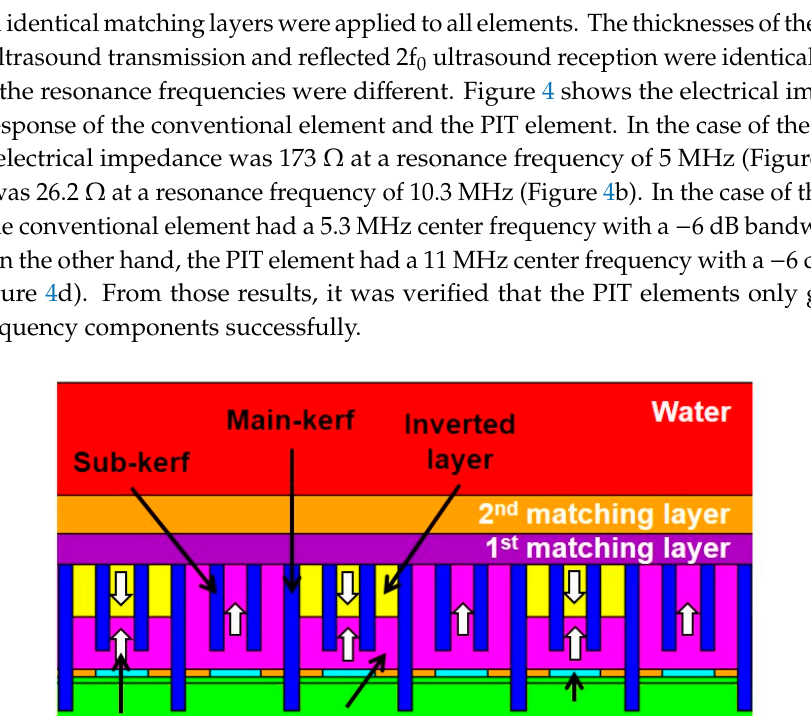
Table 2. Material properties of the PZT-5H used in the FEA simulation.